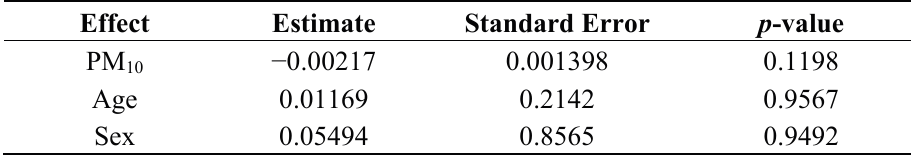
Table 8. The relationship between total symptom scores, age (<13 years) and